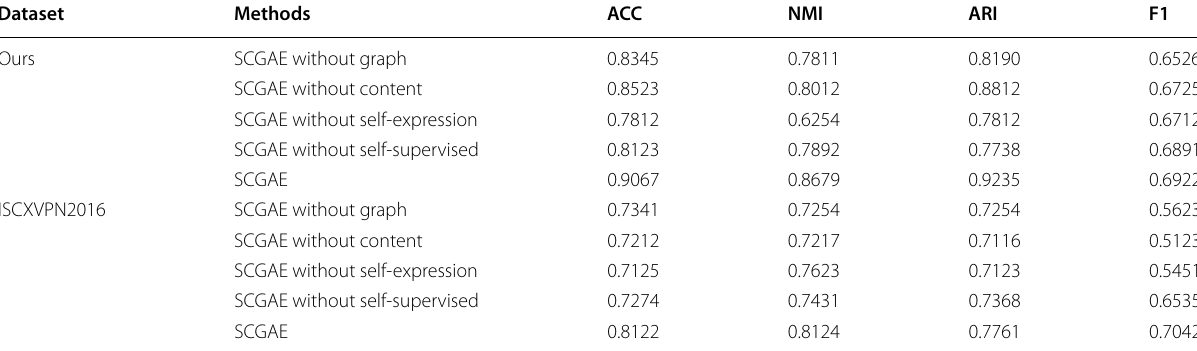
Table 5 The results of SCGAE and four incomplete clustering models Dataset